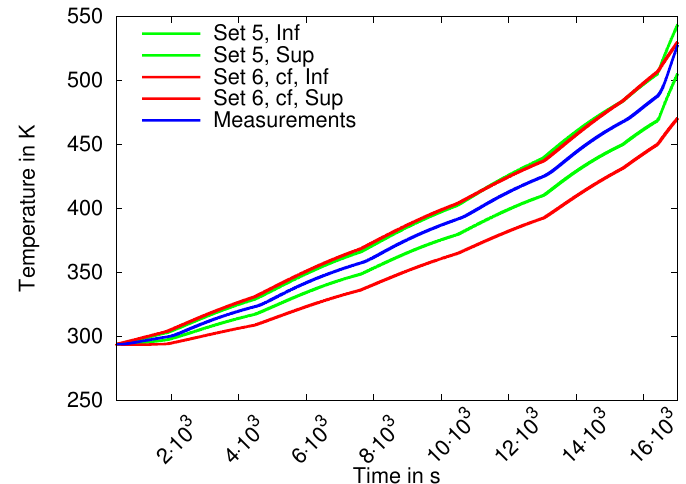
Figure 5. Simulations with uncertainty in the temperature parameters for MPL1. For Set 5, the uncertainty of 1% in all parameters can be handled very well (green curves). For Set 6 (here with parameters identified for Set 4), only the uncertainty of 5 10 − 6 % leads to meaningful results (red curves). × “Cf” means that the closed-form solution was used, otherwise